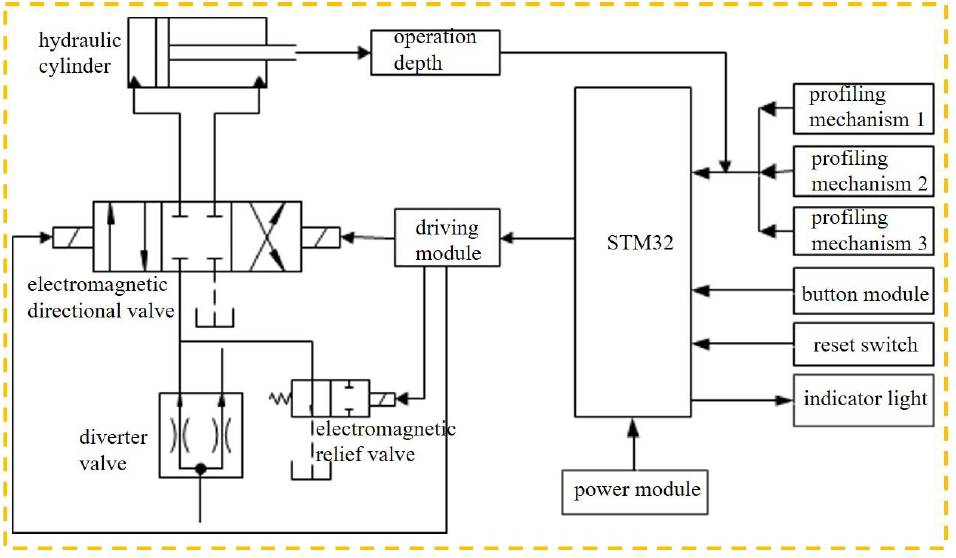
Figure 2. Principle diagram of self-adaptive control system.